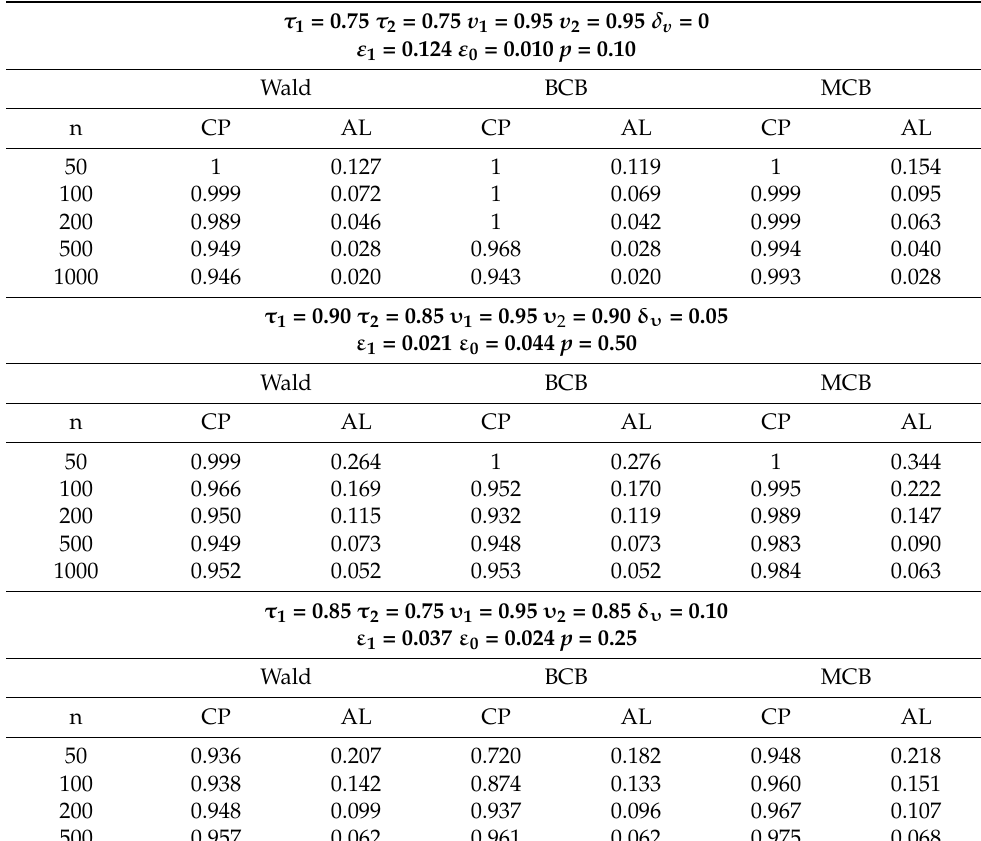
Table 4. Asymptotic behaviors of the CIs for the difference of the two negative predictive